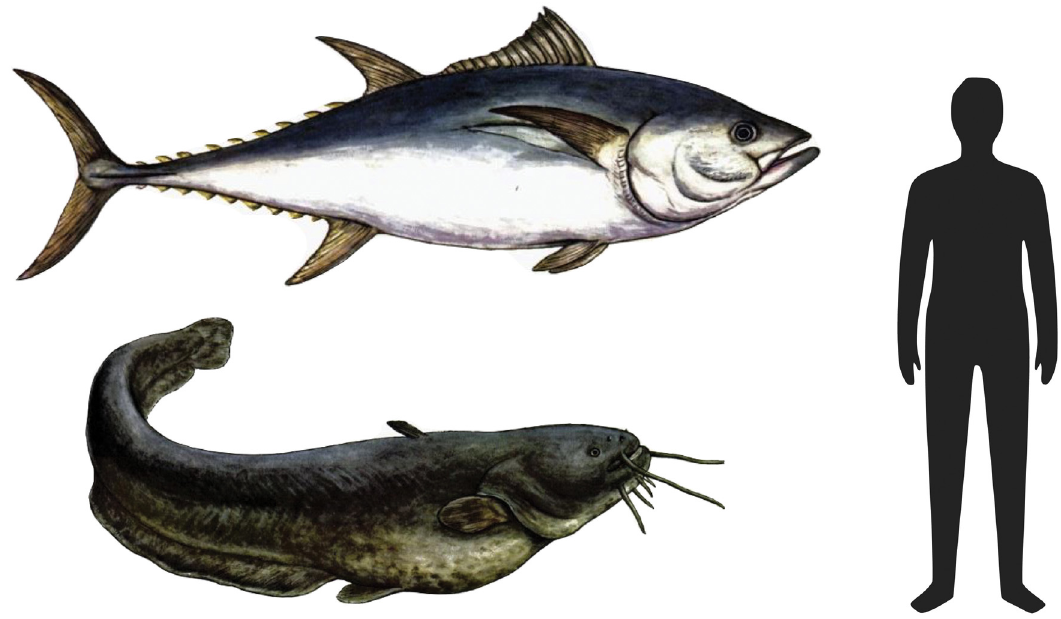
Figure 8: Atlantic Blue fi n tuna ( upper ) and Wels cat fi sh ( below ) ( from Røise, 1962, pp. 29, 47, Figures 26 and 121 ) . Approximate sizes for large individuals and an adult person. Figure by Svein V.